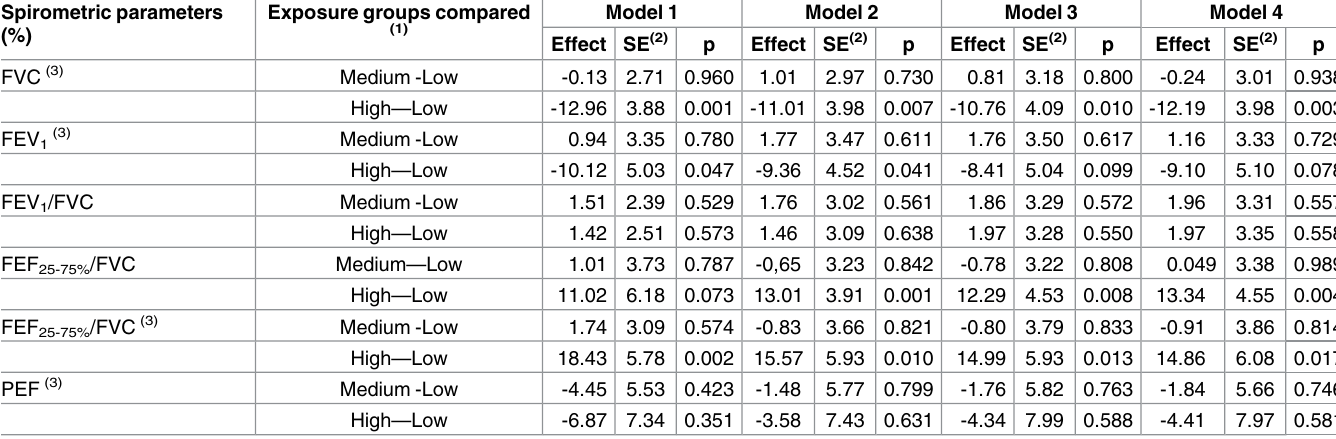
Table 3. Effects of PM 2.5 on lung function in different stages of the regression model fitting: high exposure—low exposure and medium expo- sure—low exposure. Spirometric parameters